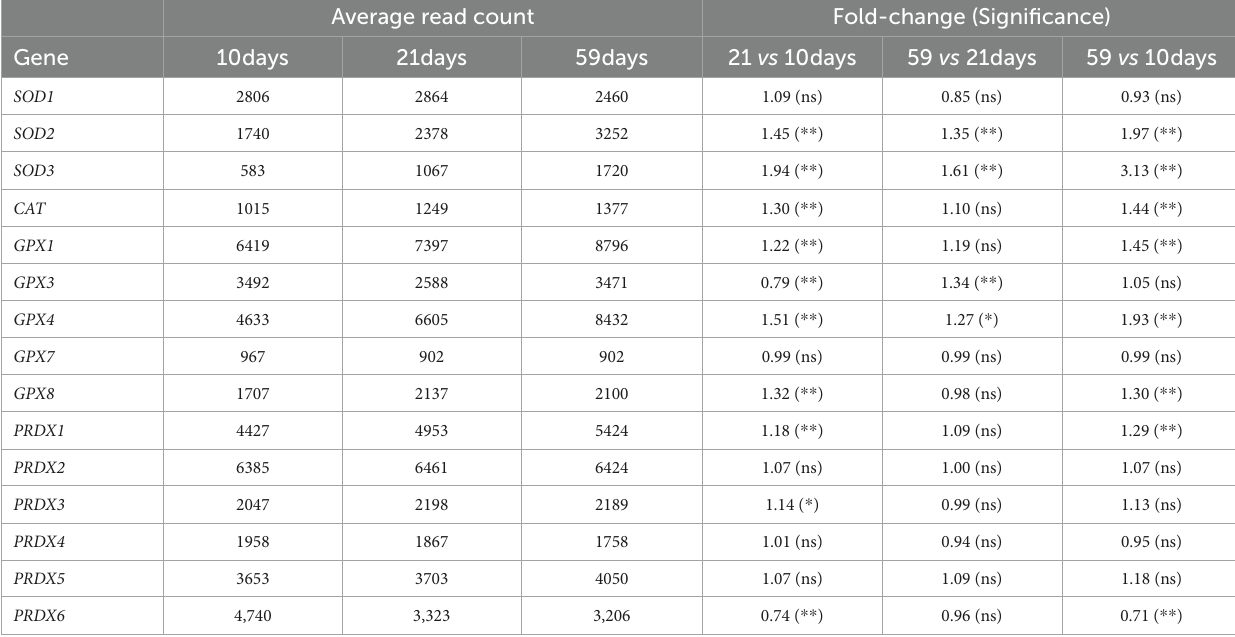
TABLE 1 Temporal changes in the gene expression of antioxidant enzymes in RPE cells at 10, 21, and 59 days in culture. Average read count Fold-change